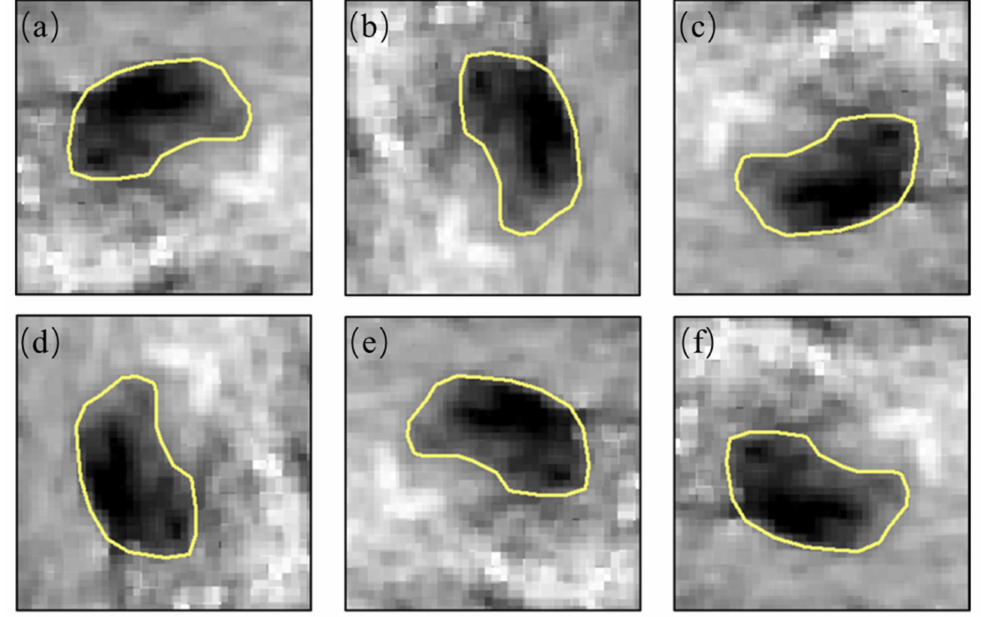
Figure 17. Schematic diagram of the data augmentation. ( a ) Original image, ( b ) Rotated 90 ◦ , ( c ) Rotated 180 ◦ , ( d ) Rotated 270 ◦ , ( e ) Flip horizontally, and ( f ) Flip vertical.